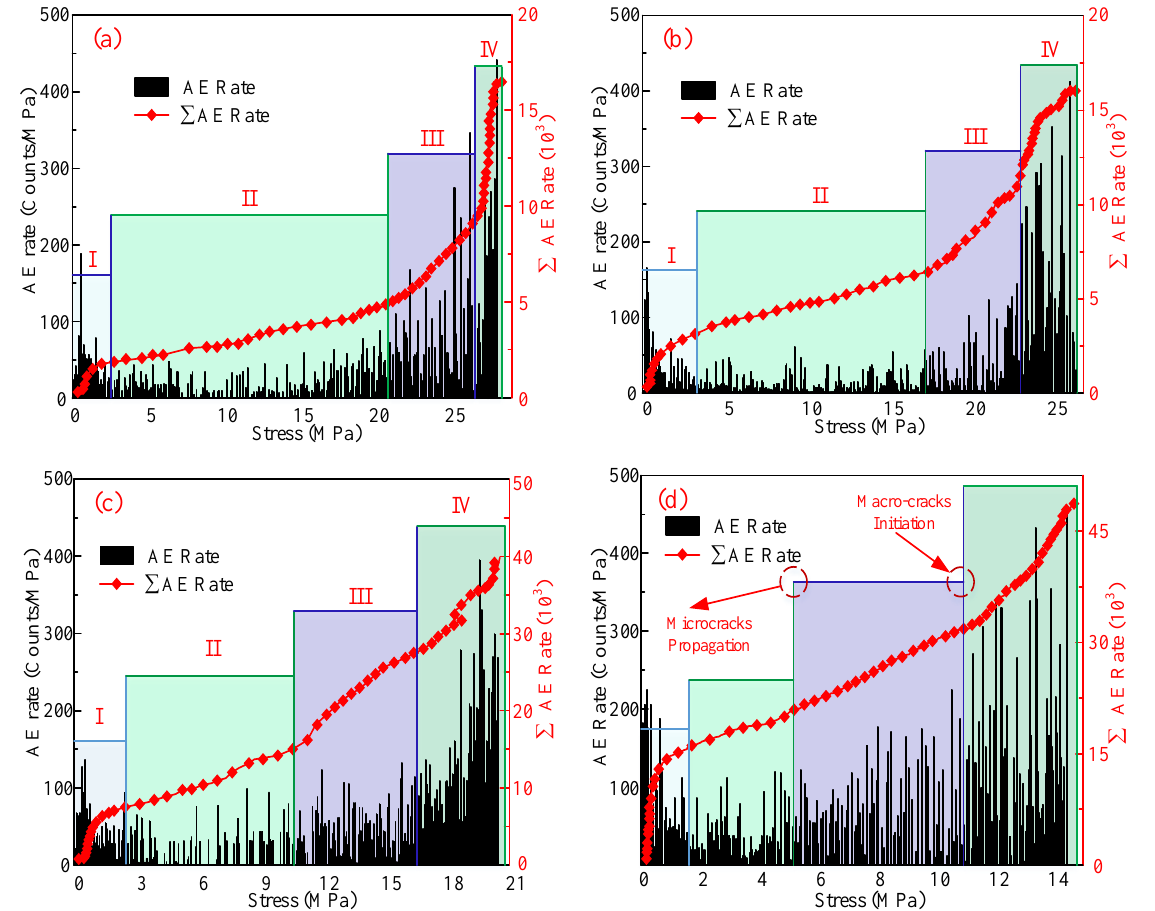
Figure 16. The relationship between the AE behavior and the stress of samples with different F-T cycles under uniaxial compression conditions: ( a – d ) represent the samples that were subjected to 0, 5, 15, and 30 F-T cycles, respectively.